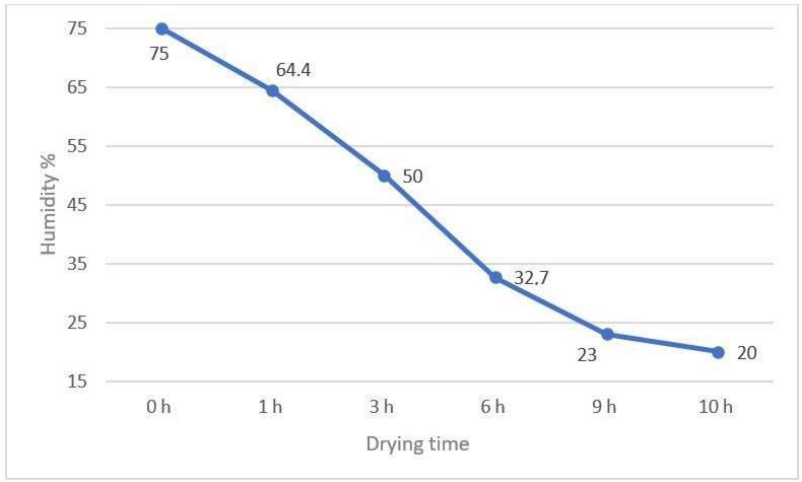
Figure 13. Drying curve—product moisture in chamber 1.